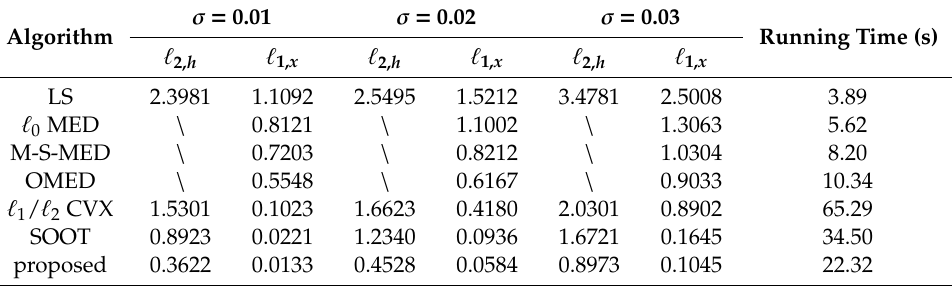
Table 1. Comparison of algorithm deconvolution results. The interpretation platform used the Intel Core i5-9400f processor with 16GB